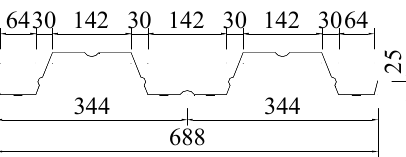
Figure 2. Cross-sectional dimensions of the profiled steel sheeting (all dimensions are in mm). Table 2. Section properties of profiled steel sheeting.